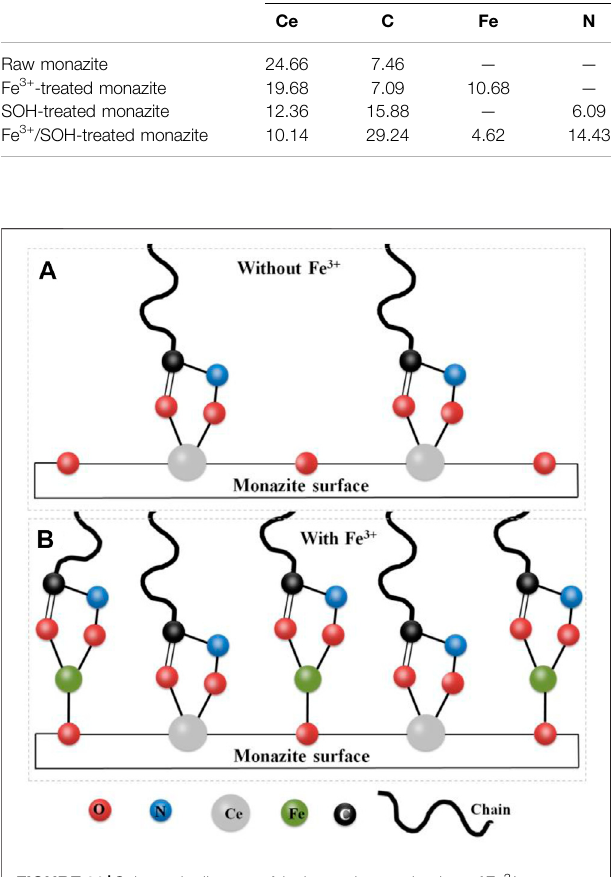
FIGURE11| SchematicdiagramoftheimprovingmechanismofFe 3+ on the adsorption of SOH on fi ne monazite fl otation: (A) without Fe 3+ ions; (B) with Fe 3+